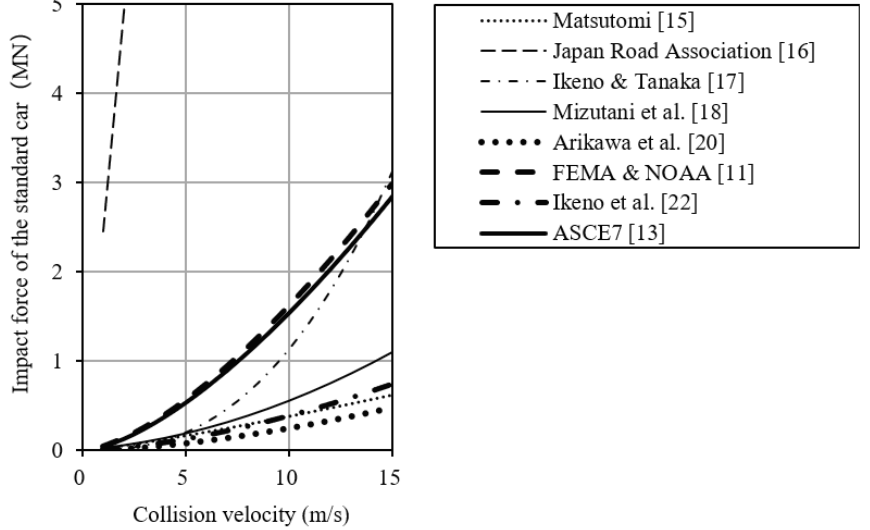
Figure 11. Impact force of the standard car.